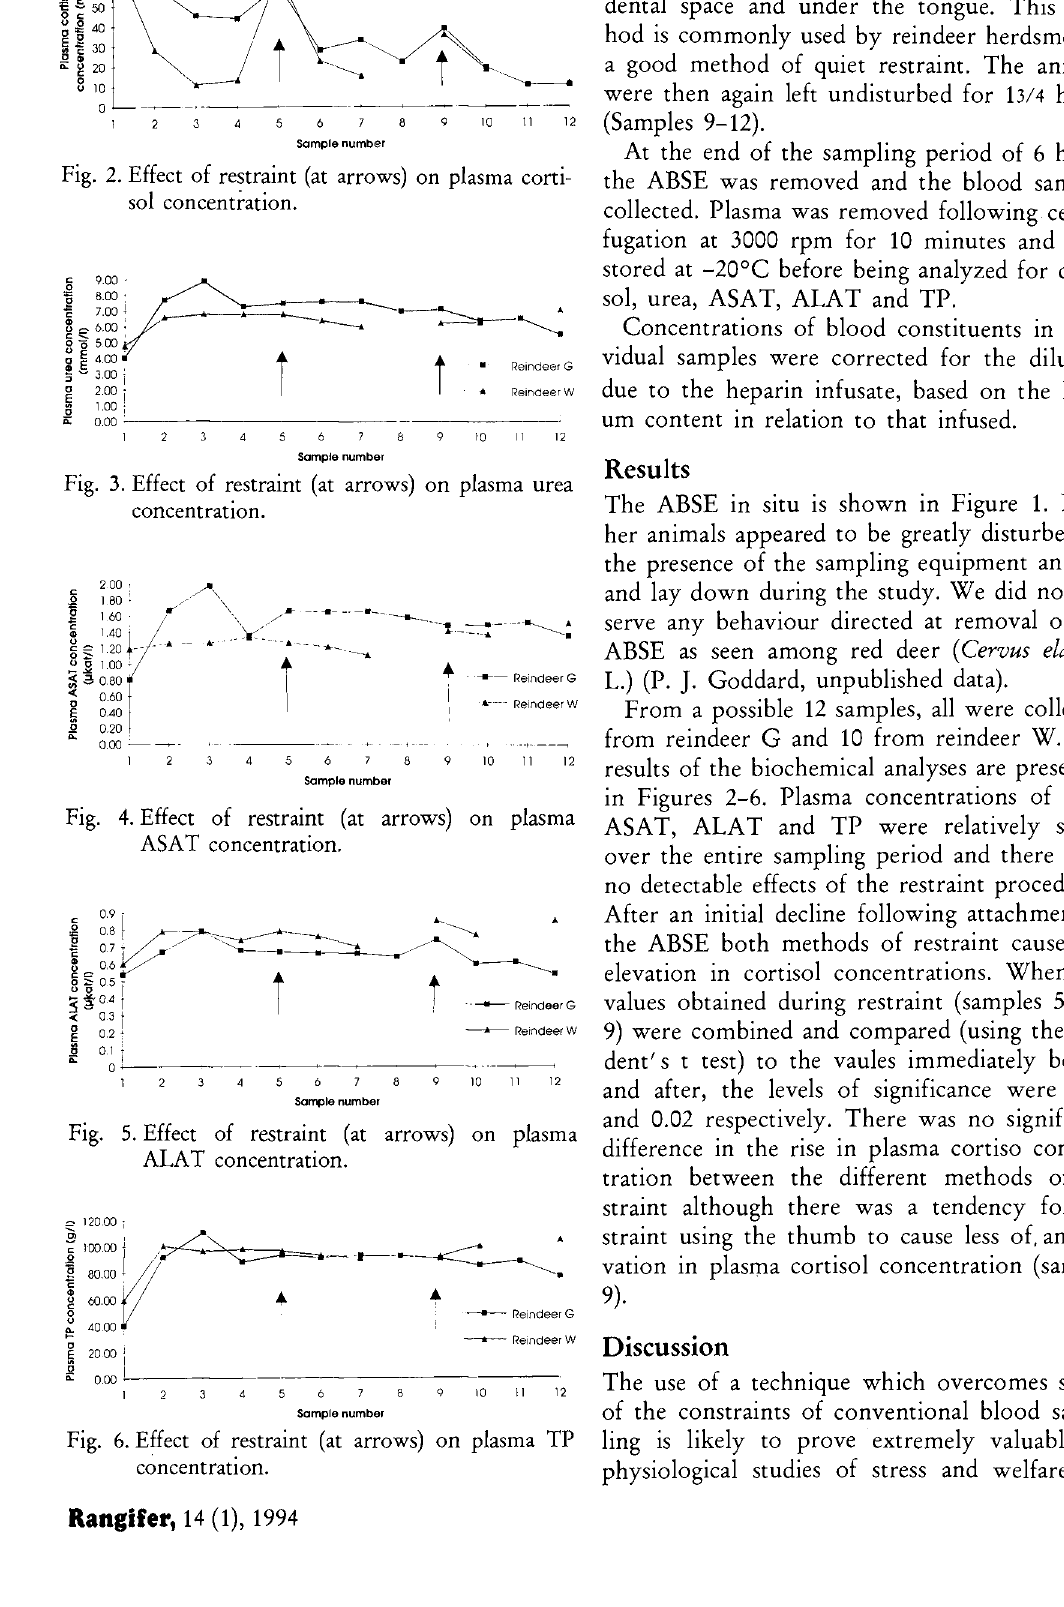
Fig. 2. Effect of restraint (at arrows) on plasma Corti sol concentration.